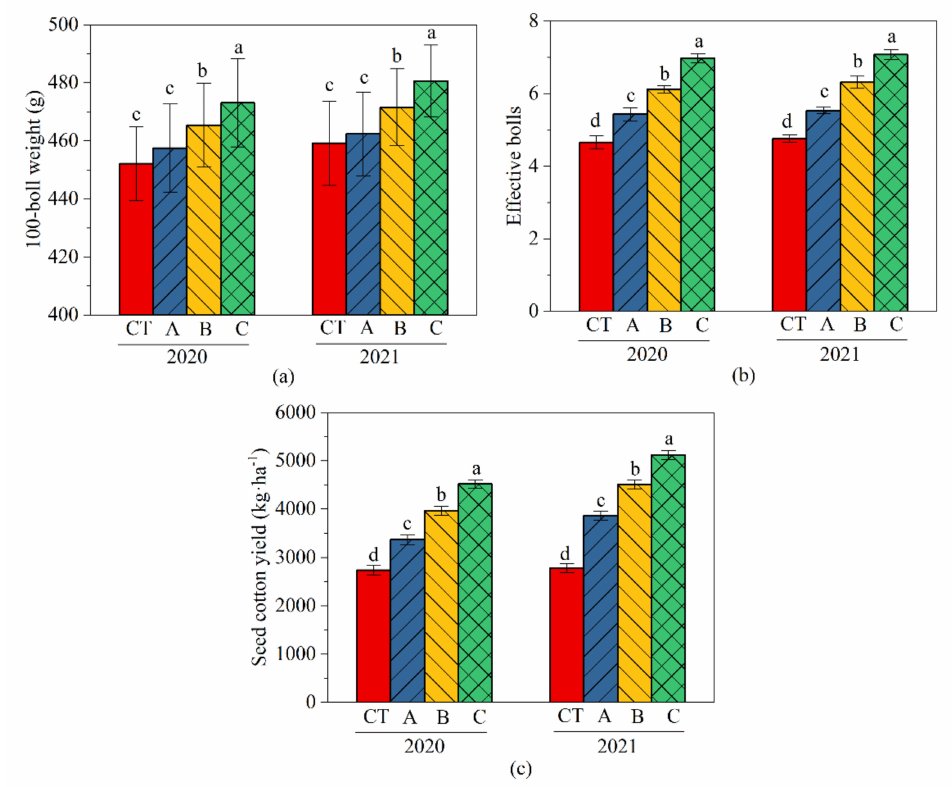
Figure 7. Effects of different smashing ridge tillage depth treatments on ( a ) 100-boll weight, ( b ) effec- tive bolls, and ( c ) yield of cotton in 2020 and 2021. Different lowercase letters represent significant differences ( p < 0.05, t -test) between treatments per year. CT, conventional tillage; A, 20 cm; B, 40 cm; C, 60